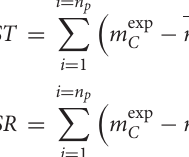
higher (24% wt.), as expected due to the loss of an important part of the raw material mass during their thermal